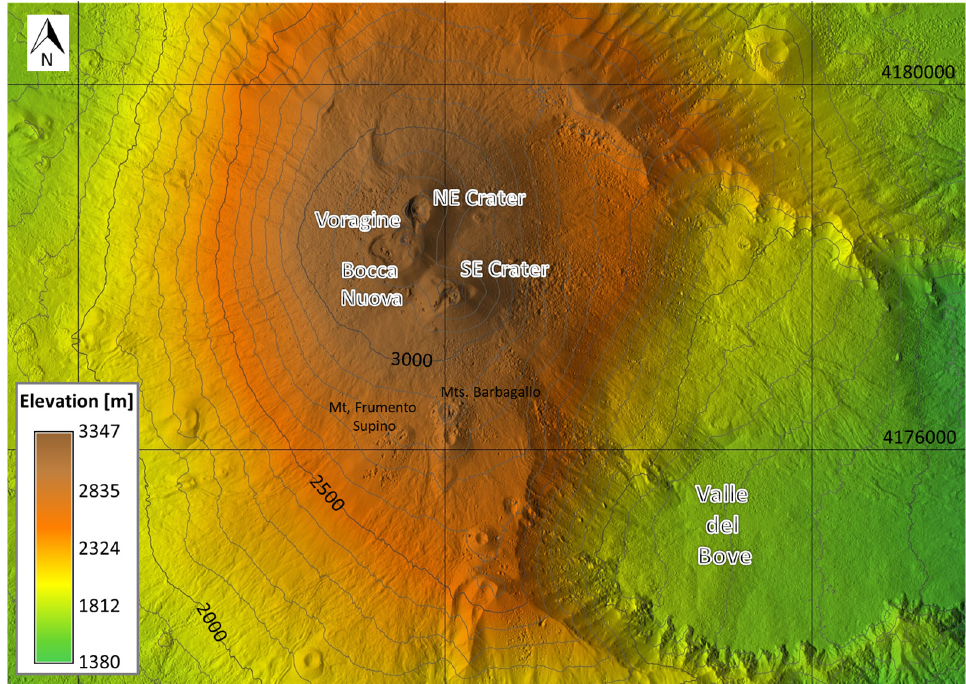
Figure 3. Digital Surface Model (DSM) of Etna volcano obtained by fusing three satellite-derived DSMs (shown in Figure 2b,d,f), updated to July 2021. Voragine (VOR, built in 1945), Bocca Nuova (BN, 1968), North-East Crater (NEC, 1911) and South-East Crater (SEC, 1971) are the present-day summit craters of the volcano. Valle del Bove is a morphological depression on the eastern flank of Etna. A more detailed map is represented as an electronic supplement.